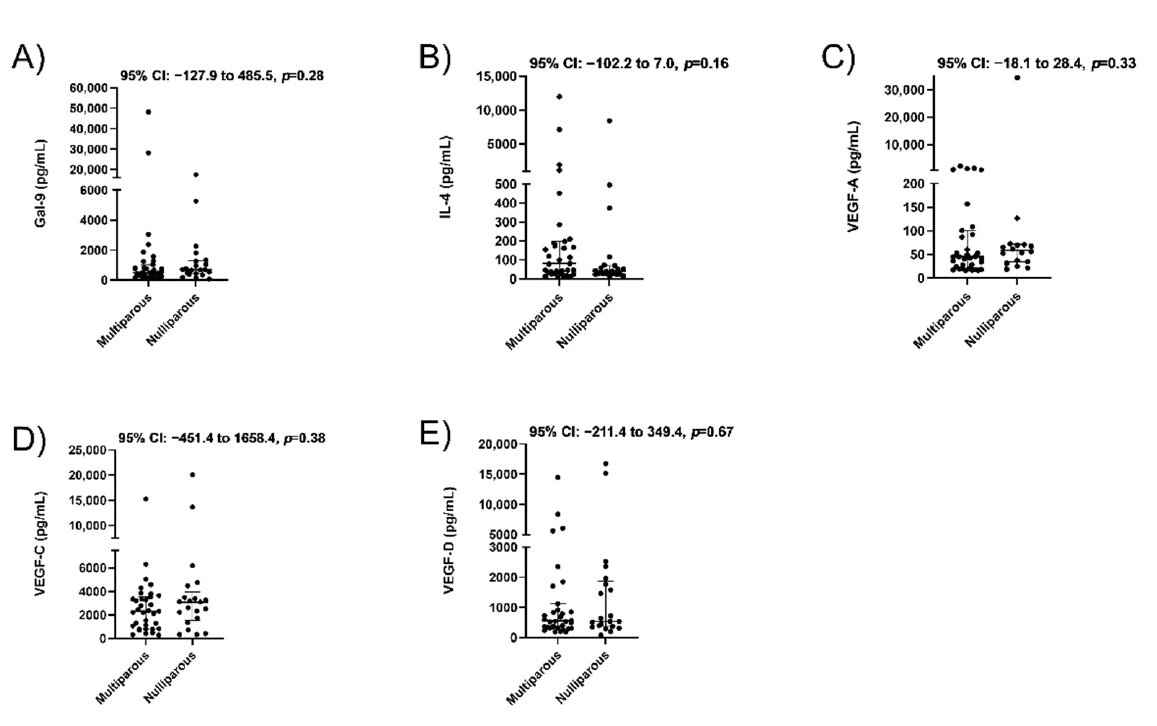
Figure 3. Maternal blood levels of immune tolerance and angiogenesis based on history (Hx) of miscarriage. Concentrations determined by ELISA for Galectin-9 ( A ), IL-4 ( B ), VEGF-A ( C ), VEGF- C ( D ), and VEGF-D ( E ). Data are displayed as the median with interquartile range along with 95% CI for the median difference between groups above each panel.